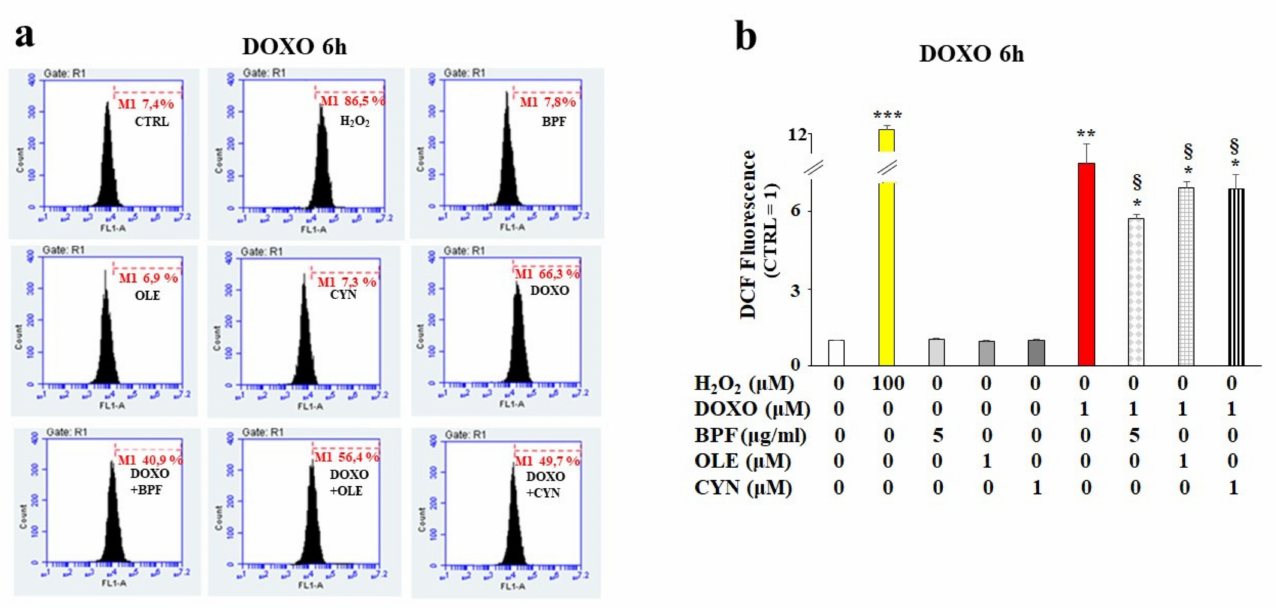
Figure 2. ROS accumulation measurement. H9c2 cells were treated with 1 µ M DOXO for 6 h or pre-treated with natural compounds for 24 h and then exposed to DOXO for 6 h. At the end of the treatment period, ROS accumulation was assessed by cytometric analysis. A right shift of the cell population indicates increases in fluorescence and ROS production compared with the control, while a left shift indicates reductions in fluorescence and ROS. A representative cytometric analysis of three independent experimental sets was performed (panel a ). In each plot, M1 represents an arbitrarily designed marker that can be used to examine fluorescence variations. 10,000 cells per sample were acquired using a FACS Accury laser flow cytometer (Becton Dickinson). The histogram presents the results of the quantification of the three independent experimental sets (panel b ). Relative quantification was conducted by setting the value of the control to 1 and comparing all other values. H 2 O 2 (100 µ M for 30 min) was used as a positive control. The values of three independent experiments are expressed as the means ± standard deviations. * denotes p < 0.05 vs. control; ** denotes p < 0.01 vs. control; *** denotes p < 0.001 vs. control. § denotes p < 0.05 vs. DOXO. The Analysis of Variance (ANOVA) was followed by the Tukey–Kramer comparisons